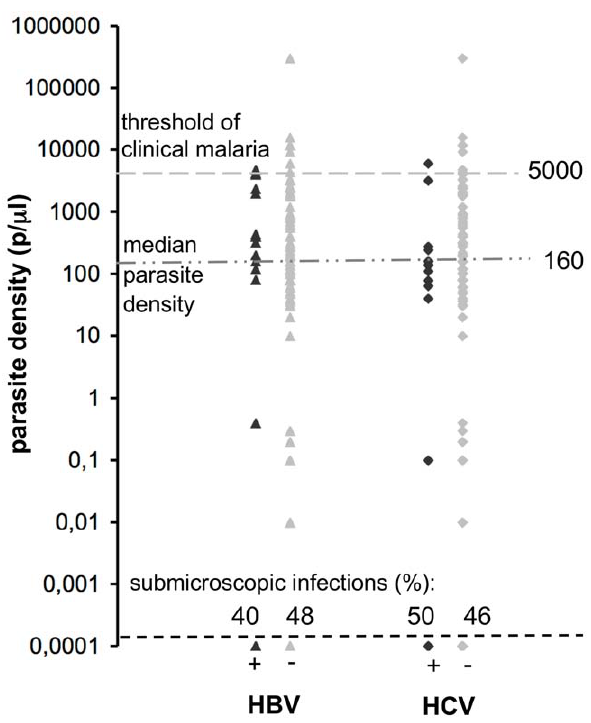
Figure 2. Parasite density distribution according to hepatitis virus serostatus. Parasite density distribution in the 203 patients in whom P. falciparum blood forms emerged after the last day of initial curative treatment, according to HBV serostatus ( m , 25 positive; , 178 negative) and HCV serostatus ( ¤ , 28 positive; , 175 negative). The median parasite density in the 203 subjects (160 p/ m L) is indicated by a horizontal dashed line. The dotted line at 5000 p/ m L corresponds to the threshold of clinical malaria.